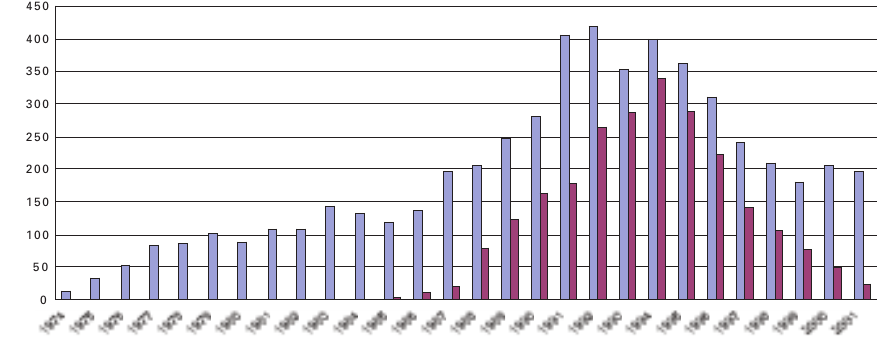
deaths in Switzer- land, 1974–2001